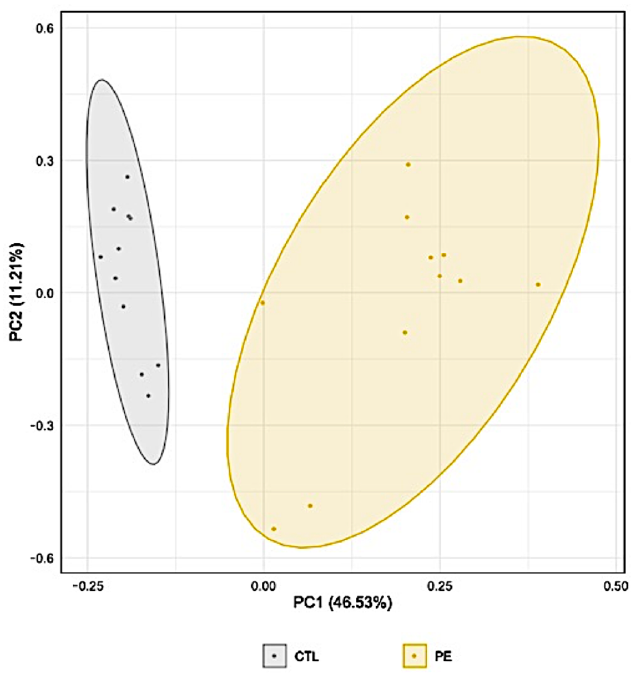
Figure 1. Principal Component Analysis (PCA) of the urinary proteomic profiles in participants with and without preeclampsia. Each point represents a participant. The axes correspond to artificial axes rebuilt by the PCA to display the maximum variability between the samples. CTL: Control; PE: Preeclampsia.